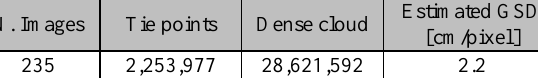
Table 9. Main details of the photogrammetric process (true colour dataset).